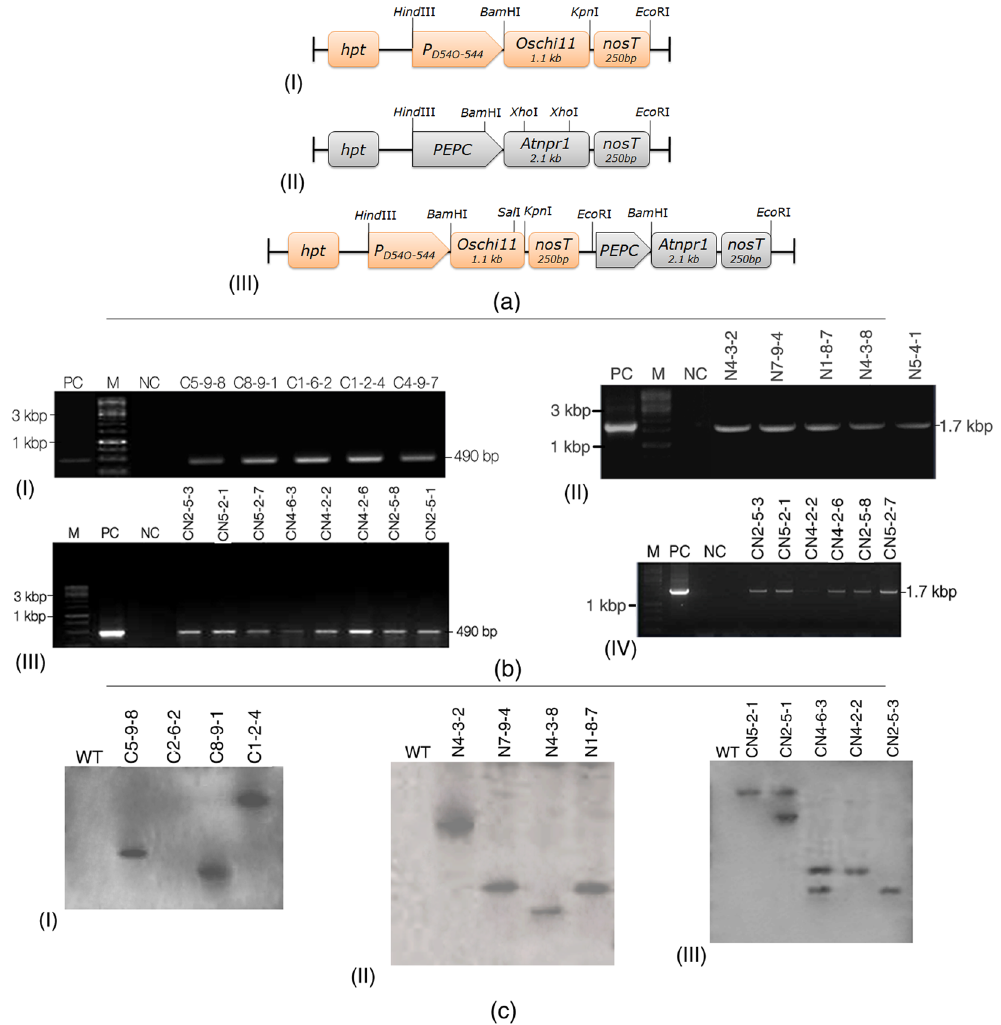
Figure 1. Diagrammatic representation of gene constructs and molecular evaluation of transgenic rice lines. ( a ) (I) Schematic representation of T-DNA construct harboring OsCHI11 gene under the green tissue-specific promoter P D54O-544 used for rice transformation. (II) Diagrammatic representation of T-DNA construct AtNPR1 gene placed under the control of maize green tissue-specific PEPC promoter. (III) Diagrammatic representation of the T-DNA construct used to transform mature embryogenic calli of jaldi-13 rice variety. OsCHI11 and AtNPR1 genes under the control of the rice green tissue-specific promoter ( P D54O–544 ) and maize green tissue-specific promoter ( PEPC ), respectively. ( b ) (I) PCR analysis of T 2 transgenic rice plants with partial gene-specific ( OsCHI11 ) primers which amplified 490 bp product. (II) PCR analysis of T 2 transgenic rice plants with partial gene-specific ( AtNPR1 ) primers which amplified 1.7Kbp product. (III) PCR based screening of T 2 transgenic and non-transformed WT performed with partial gene specific primer ( OsCHI11 ) which amplified 490 bp product. (IV) PCR analysis performed with partial gene specific primer ( AtNPR1 ) showing amplification of 1.7Kbp product. PC-Positive control and NC- Negative control. ( c ) (I) Southern blot analysis of T 2 transgenic plants (C): genomic DNA digested with Sal I restriction enzyme and probed with 1.1 kbp HPT gene fragment. (II) Southern blot analysis T 2 transgenic plants (N): genomic DNA digested by EcoR I restriction enzyme and probed with 1.1 kbp HPT gene fragment. (III) Southern hybridization analysis of T 2 transgenic plants (C-N): genomic DNA was digested with Sal I restriction enzyme and probed with 1.1 kbp HPT ( hygromycin phosphotransferase ) gene fragment. WT represents wild